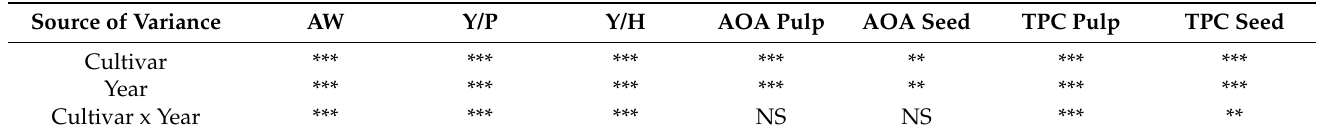
Table 3. Effect of the cultivar and growing year on the mean yield and qualitative parameters of okra